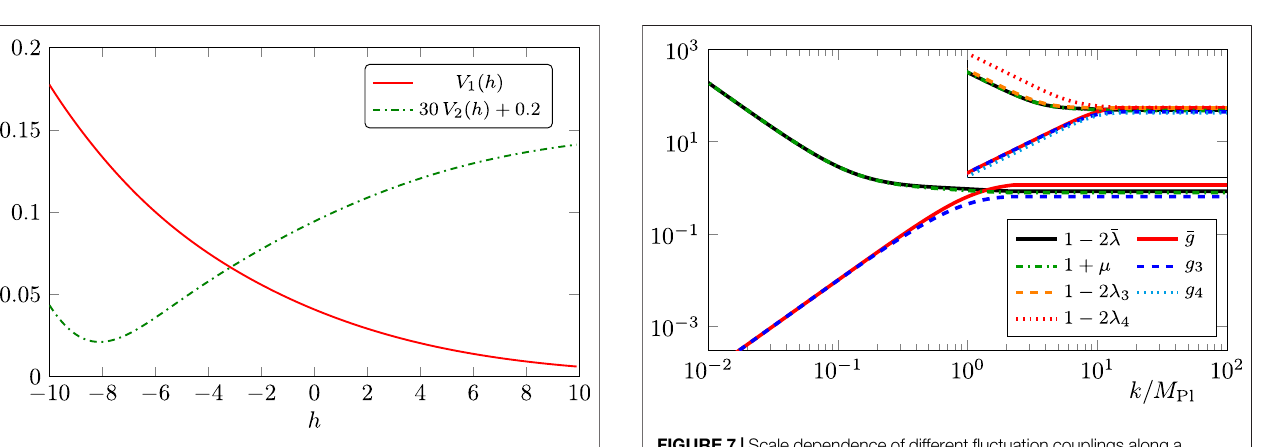
FIGURE 7 | Scale dependence of different fl uctuation couplings along a trajectory from the UV fi xed point 93 to the IR. In the IR, the couplings fl ow according to their canonical running. For small k , g and g 3 as well as λ and µ are related via the simpli fi ed NI ( 95 ). The inset shows the complete set of couplings. The results are taken from